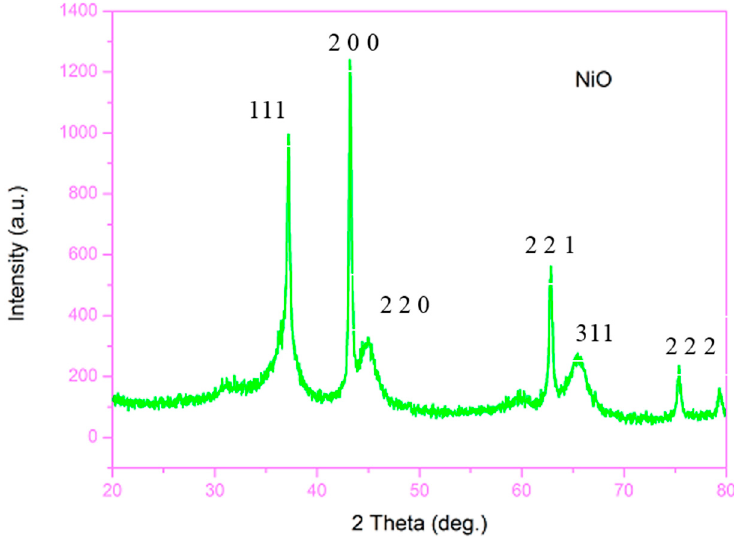
Figure 1. X-ray diffraction (XRD) pattern of nickel oxide.